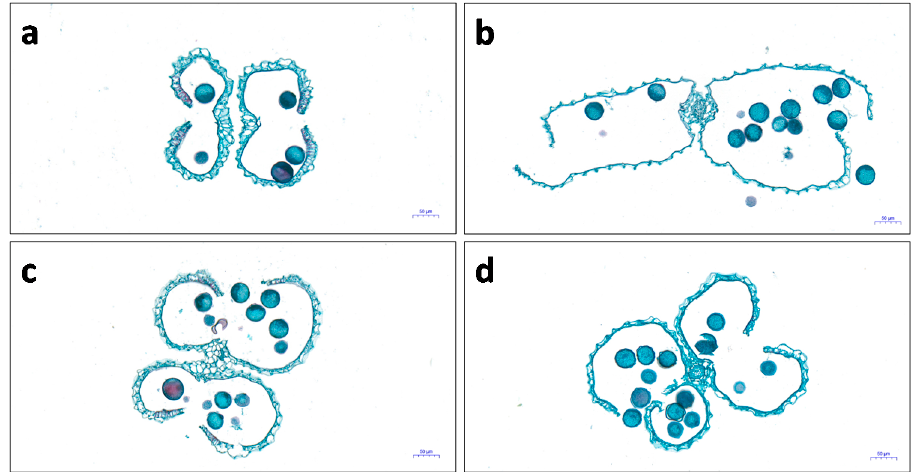
Figure 3. Microstructure of anthers of SDWG005 and 9311 in the control and after 12 h of heat treatment. Anthers of 9311 plants in the ( a ) control and ( b ) heat treatments, and anthers of SDWG005 plants in the ( c ) control and ( d ) heat treatments. Scale bar = 50 µm.